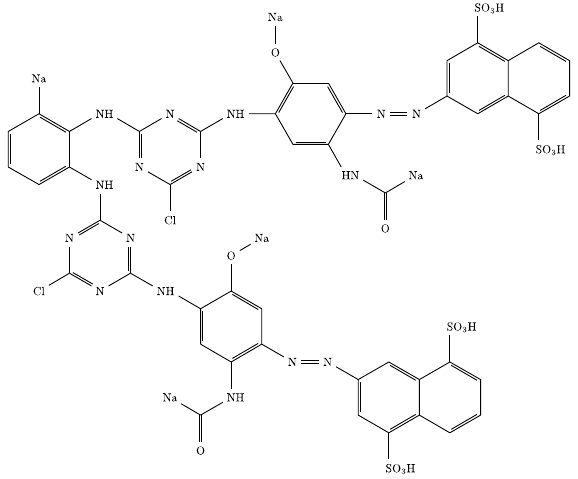
Figure 12. Chemical structure CAS No. 124448-55-1.